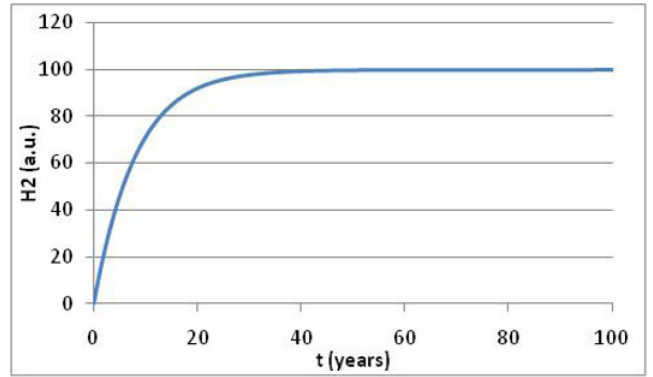
Fig. 7: Dihydrogen production vs. time (w = 0,64 ; porosity = 0,44 ; dose rate = 165 Gy/h).